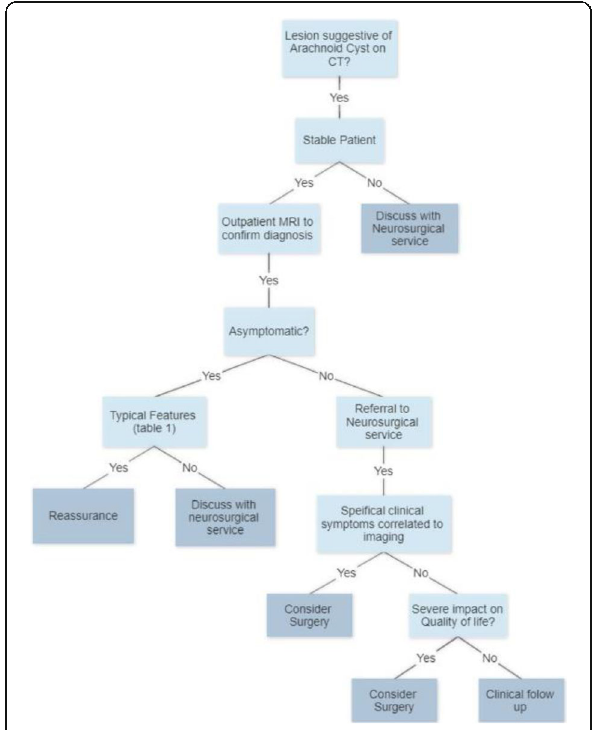
Fig. 1 (abstract P36). See text for description